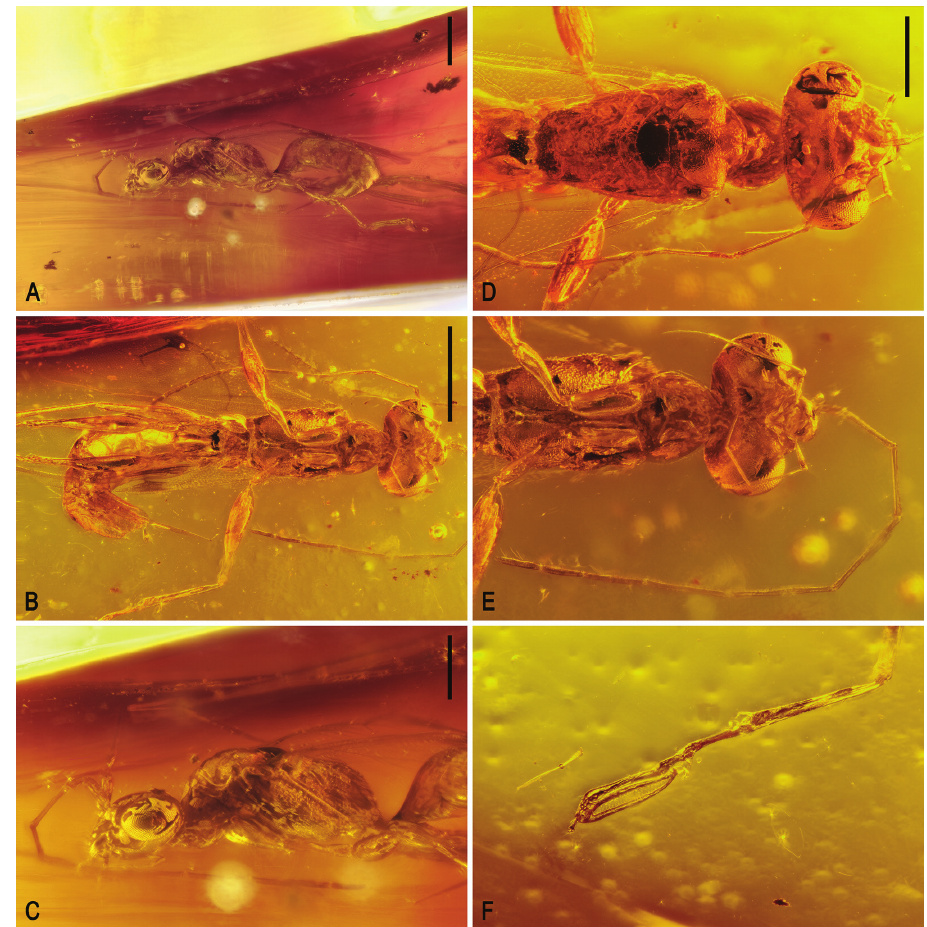
Figure 3. † Thaumatodryinus priscus (Olmi, 1998), female holotype. A habitus, lateral view B habitus, ventral view C head and mesosoma, lateral view D head and mesosoma, dorsal view E head and meso- soma, ventral view F apical portion of fore leg, with details of the chela. Scales: 1 mm ( A ), 1 mm ( B ), 0.5 mm ( C ), 0.5 mm ( D–F